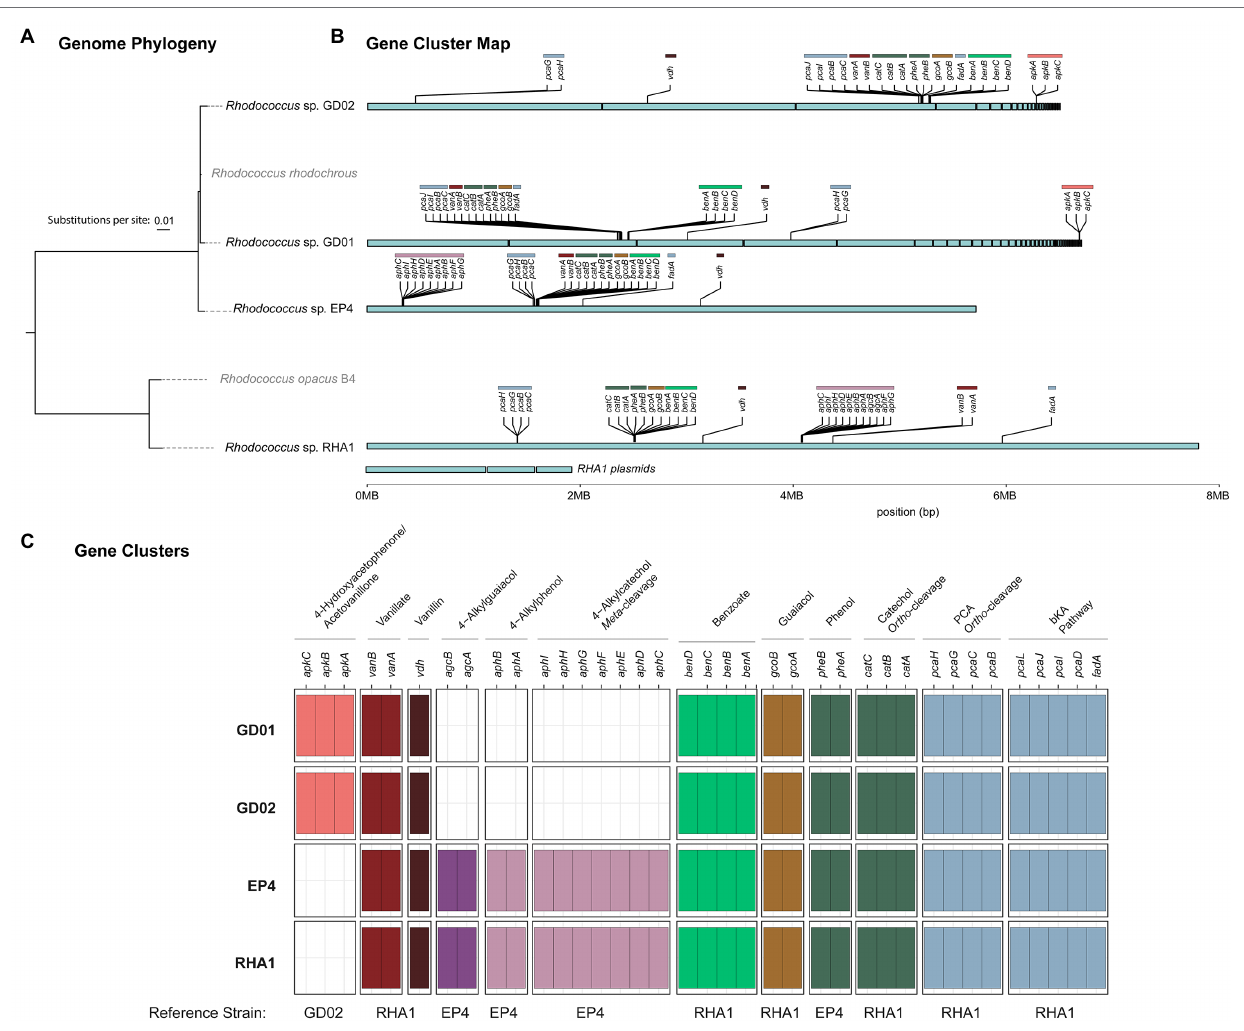
FIGURE 1 | Presence of select aromatic catabolic genes in the GD01, GD02, EP4, and RHA1 genomes. (A) Genome phylogeny created using IQ-Tree2 from MAFFT alignment of 120 concatenated single-copy genes showing the placement of GD01, GD02, and EP4 in the Rhodococcus rhodochrous clade. (B) The assembly contigs for each genome are plotted to show the location of gene clusters involved in degradation of select aromatic compounds. (C) Summary plot of select aromatic catabolic genes in the GD01, GD02, and EP4 (accession number GCA_003004765.2) and RHA1 (accession number GCA_000014565.1) genomes. A custom database of genes for each pathway was assembled, and the presence/absence of genes in each strain were identified by BLAST search, with a threshold of 25% identity and E -value of 1E − 30